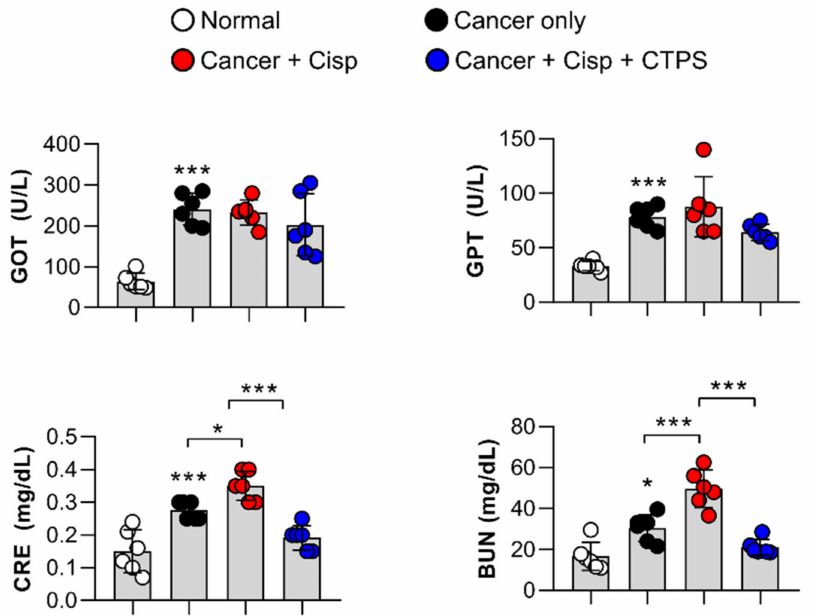
Figure 7. CTPS reduced the serum creatine and BUN levels in cisplatin-treated mice. Serum levels of GOT, GPT, CRE, and BUN were measured using an automatic biochemical analyzer. Data are expressed as the mean ± standard deviation ( n = 6). * p < 0.05 and *** p < 0.001 represent significant differences. CTPS, Cudrania tricuspidata -derived polysaccharides; cisp, cisplatin; GOT, glutamate oxaloacetate transaminase; GPT, glutamate pyruvate transaminase; BUN, blood urea nitrogen; CRE,